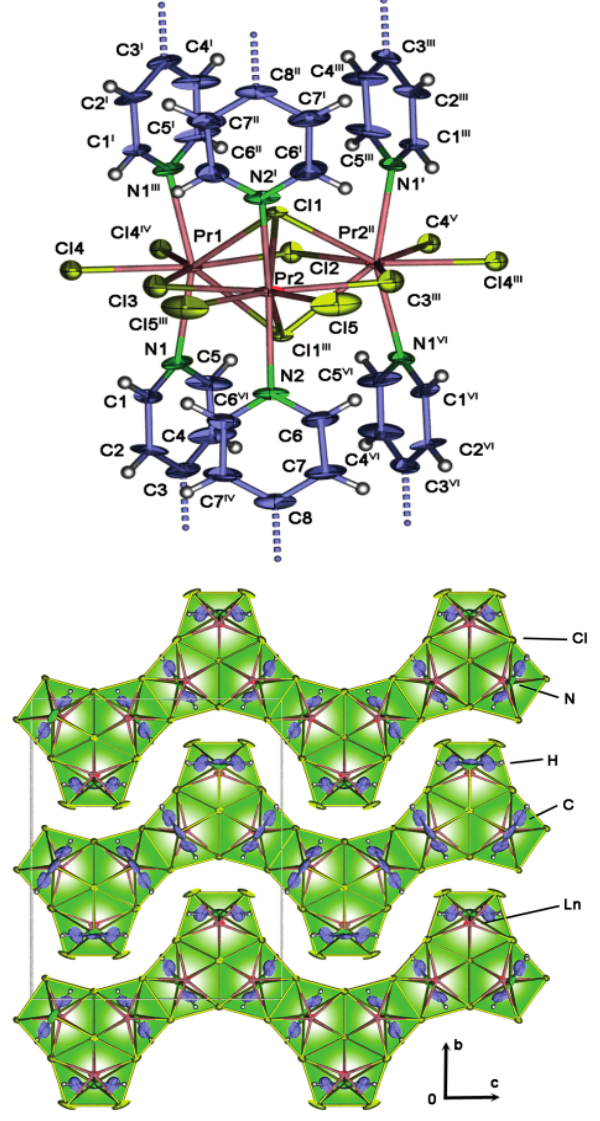
Figure 9. The cluster-like arrangement in 2 ∞ [Pr 3 Cl 9 (bipy) 3 ], H-atoms are omitted for clarity; symmetry operations: I − x, y, z; II − x, y, 3/2 − z; III − x, y, 3/2 − z; IV x, − y, 2 − z; V − x, − y, z − 1/2; VI x, y, 3/2 − z ( top ). View along the a-axis of the crystal-structure of 2 ∞ [Ln 3 Cl 9 (bipy) 3 ] for Ln = Pr ( 8 ) ( bottom ); thermal ellipsoids are depicted with 50%